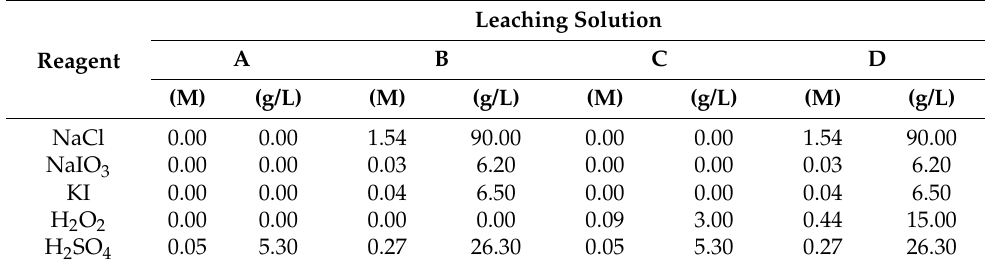
Table 2. Leaching solution